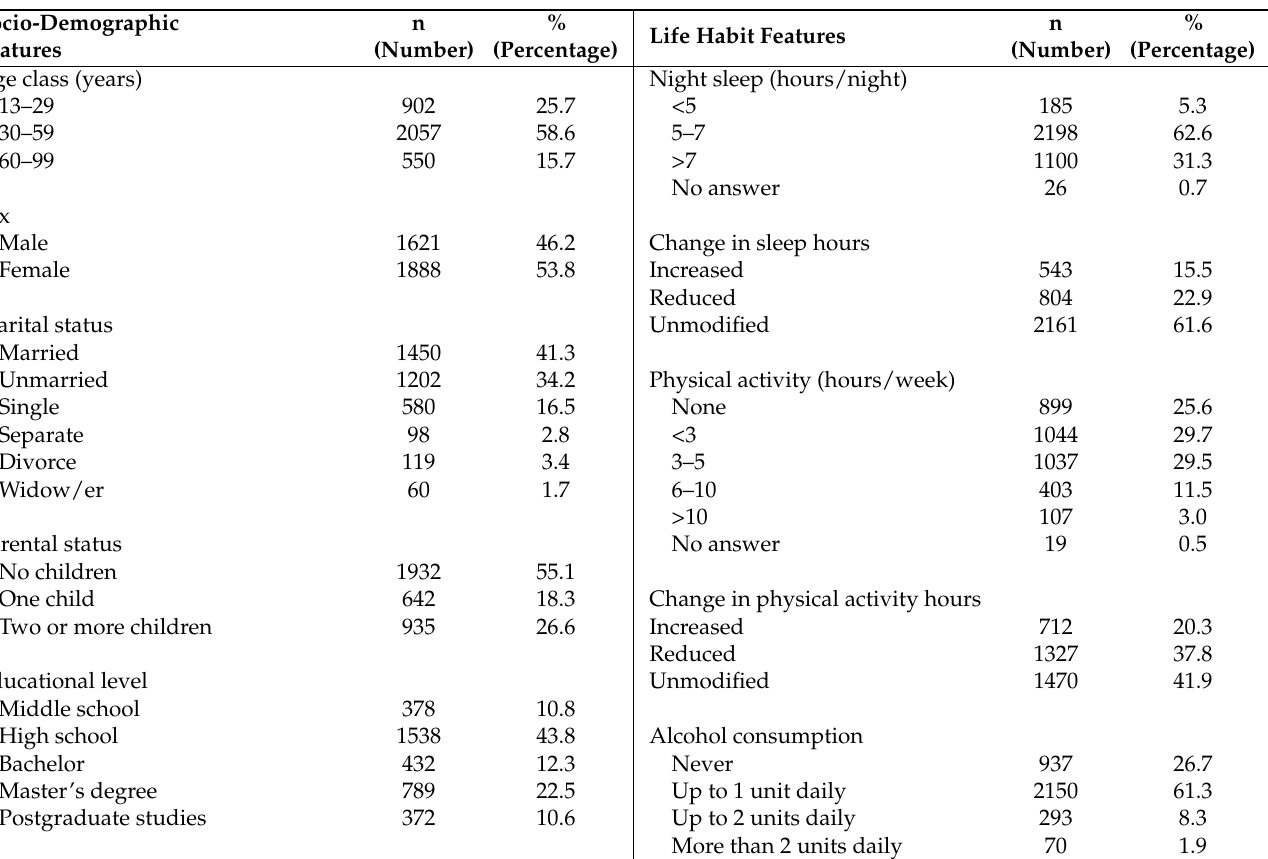
Table 1. Sociodemographic, life habits, GAD-7, and PHQ-9 scores at the time of completion of the